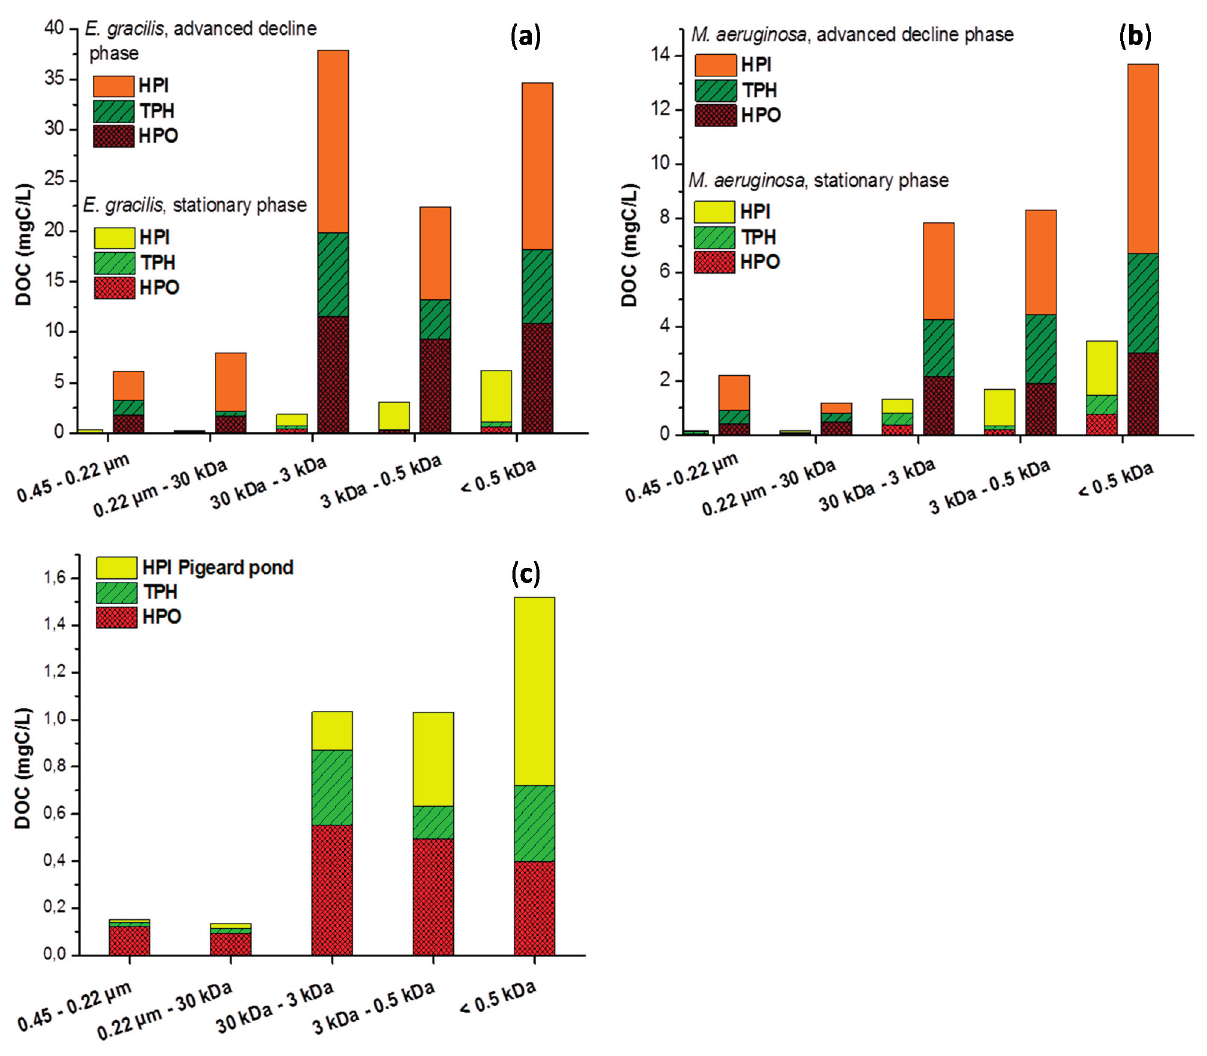
Figure 4. Concentration of HPO, TPH and HPI fractions in the different size fractions during the stationary and advanced decline phases for E. gracilis ( a ) and M. aeruginosa ( b ) and during winter for Pigeard pond ( c